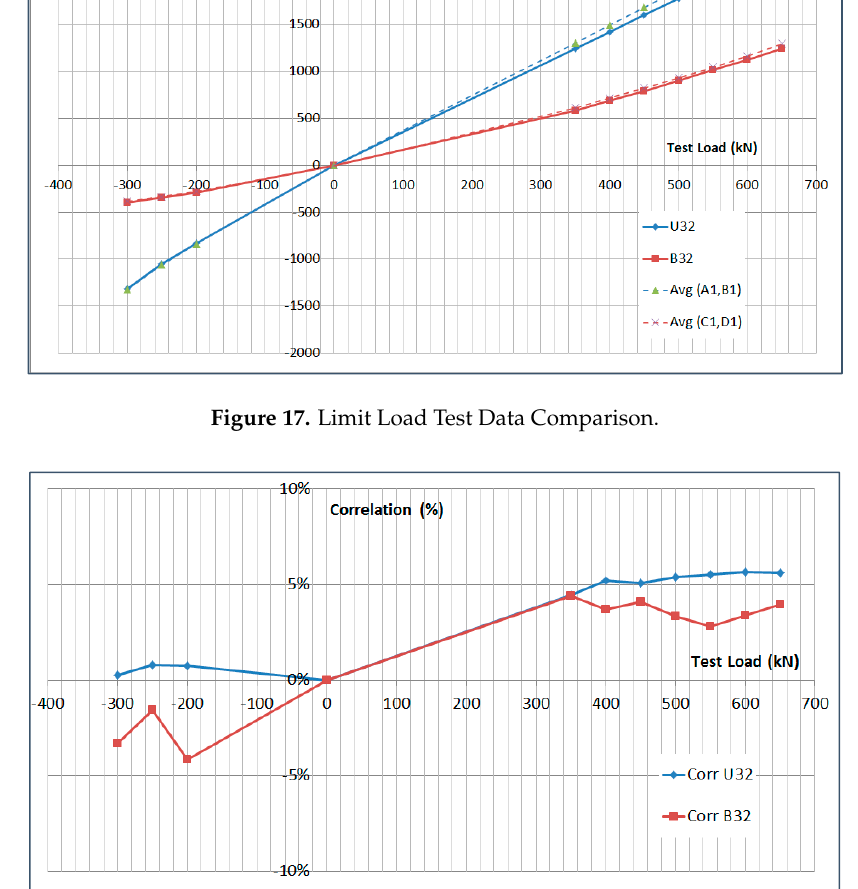
Figure 18. Limit Load Test Data Correlation.